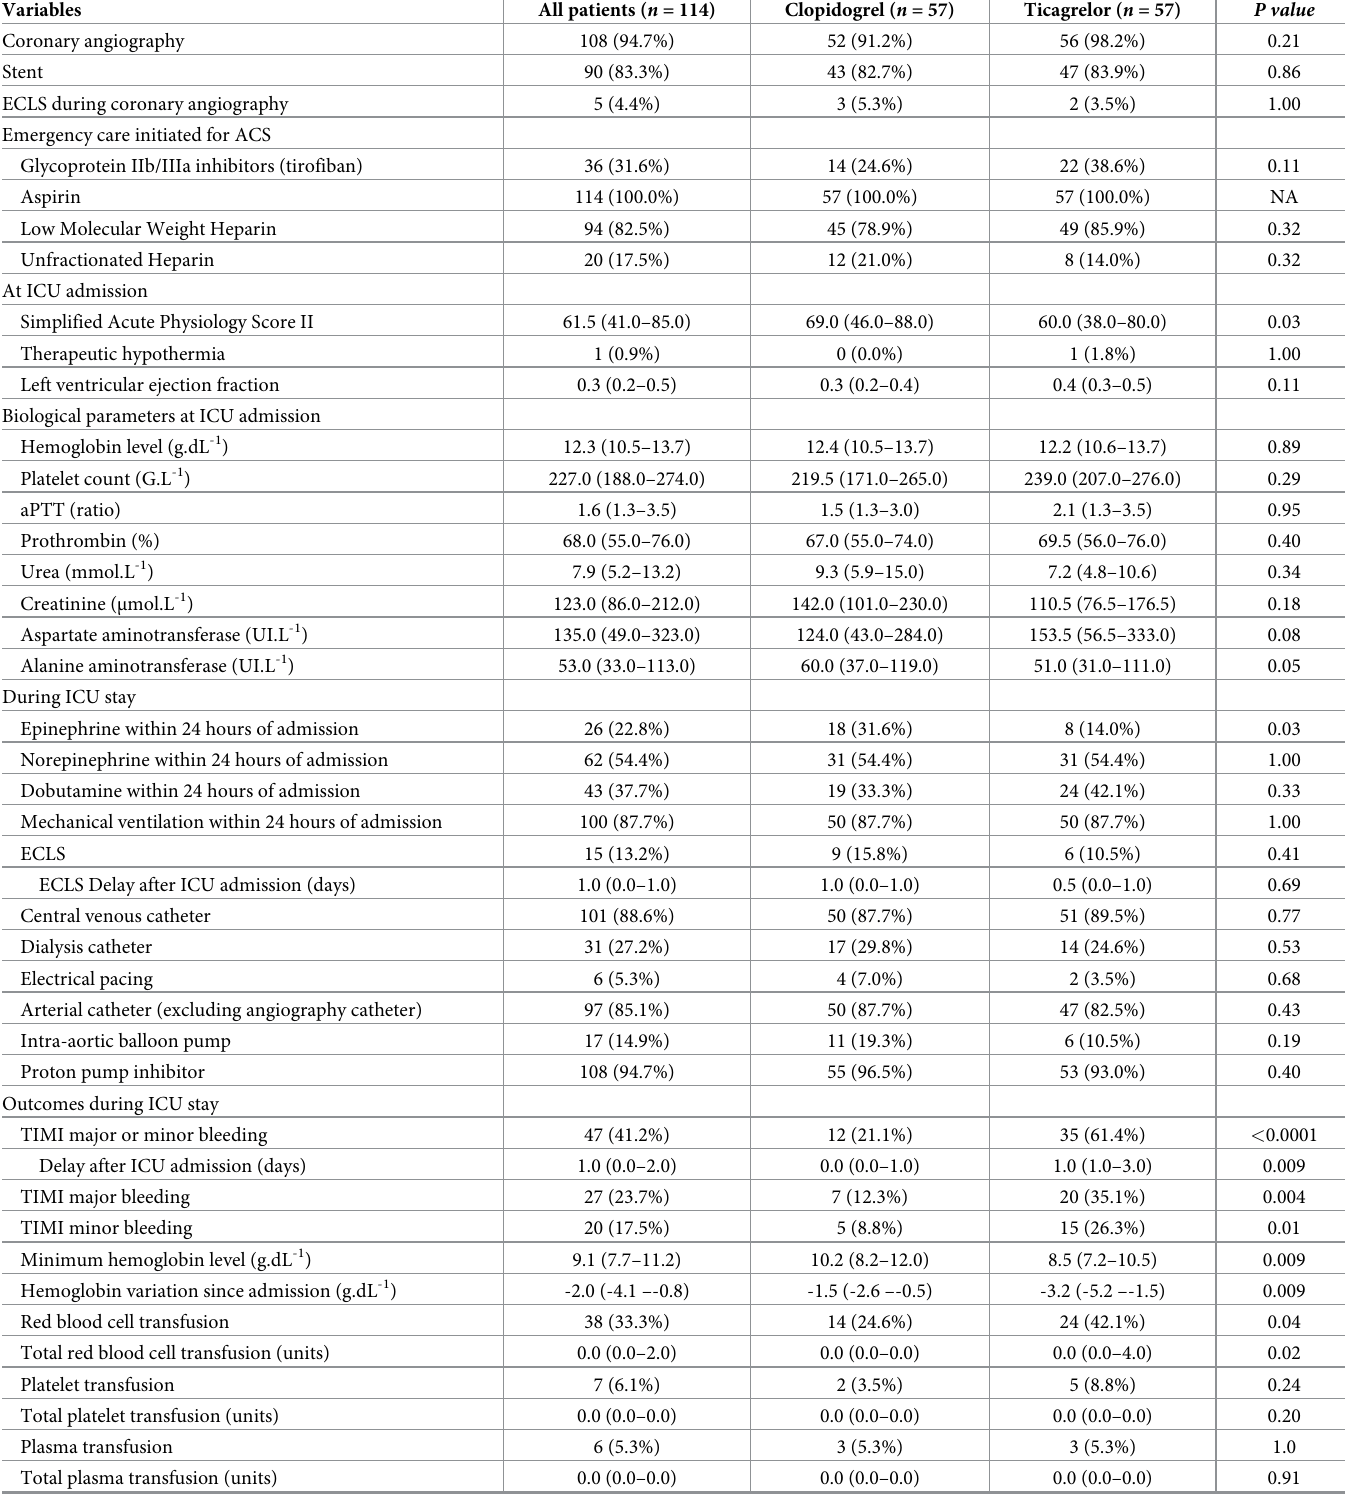
Table 2. Characteristics and outcomes of the 114 matched patients between study inclusion and ICU discharge or